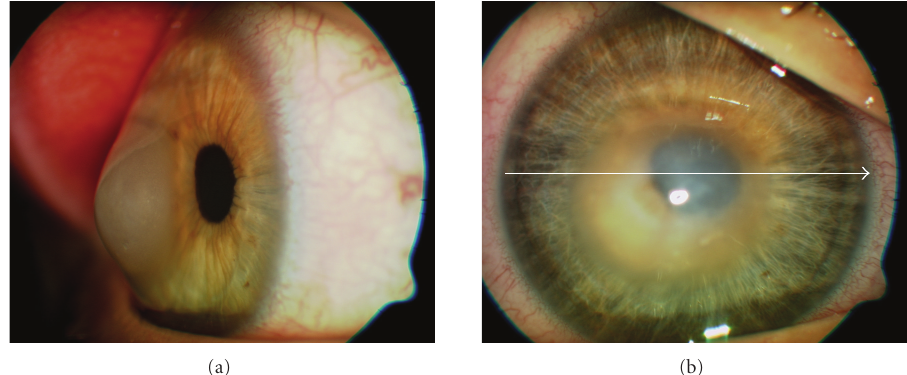
Figure 1: The photograph demonstrates the central keratectasia with an anterior corneal steepening from the side (1a). The thinned central cornea within the 7mm central optical zone is “bulged” forward with a edematous swelling of approximately 1450 µ m similar to an acute keratoconus. Figure 1(b): the photograph of the frontside demonstrated the location of the corresponding OCT-scan.